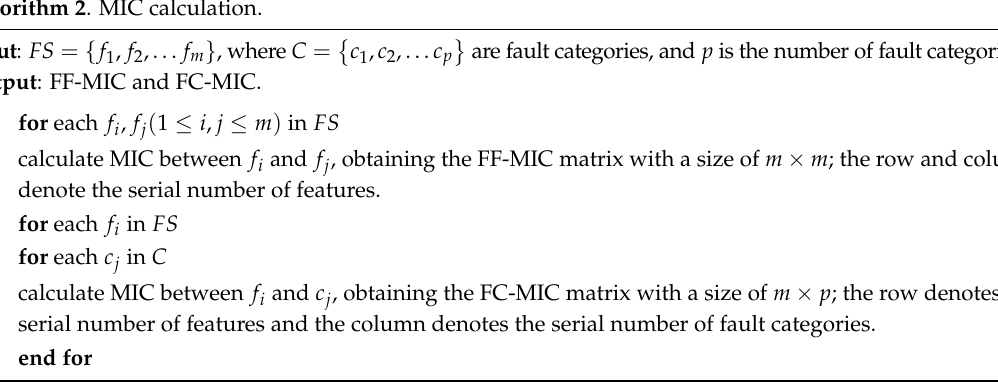
Algorithm 2 . MIC